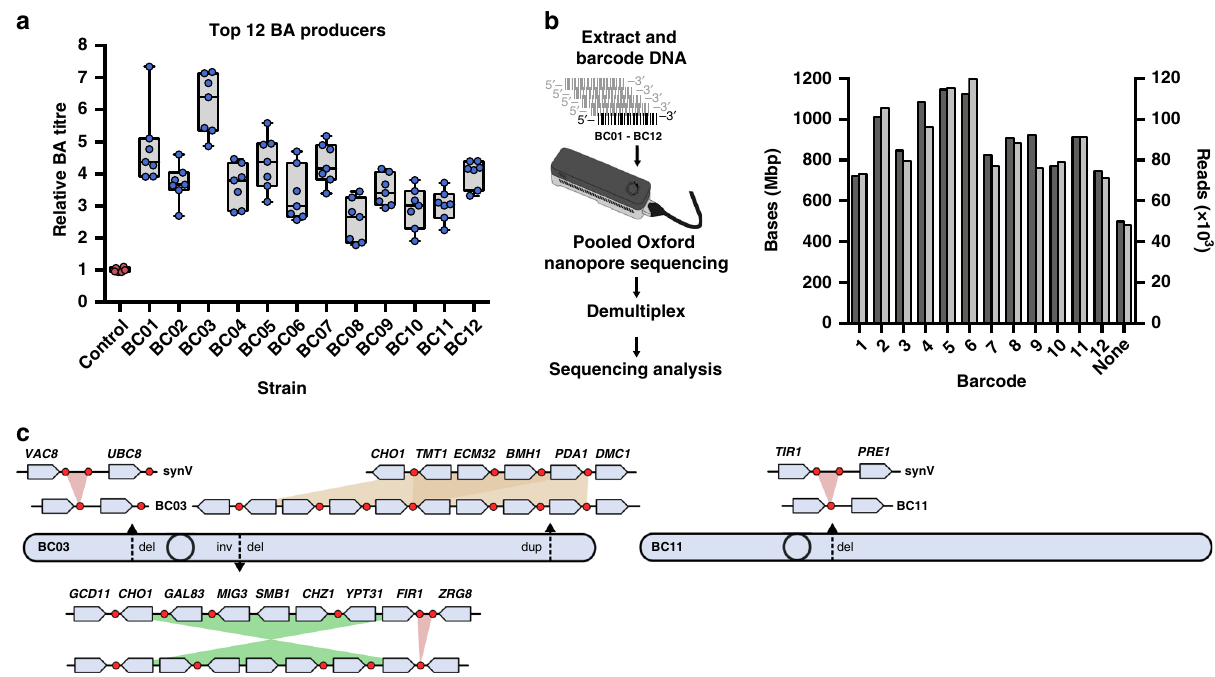
Fig. 2 Phenotype and genotyping of the top 12 BA producers by ultra-fast LC-MS and multiplexed nanopore sequencing. a The top 12 strains from the initial screen (BC01 – BC12), and the control strain (yGG066), were subject to reanalysis with n = 7 ( n = 6 for the control strain) biologically independent samples using the same extraction and LC-MS work fl ow as in the initial screen. Data are presented as a box plot centred around the mean with bounds between the 25th and 75th percentile. Whiskers represent minima and maxima. b DNA from each of the top 12 strains was extracted and barcoded with 12 unique barcodes (BC01 – BC12). The pooled DNA was then sequenced over 48 h. Throughput of bases (dark grey) and reads (light grey) was monitored to ensure no bias was introduced for a particular barcode. c Sequence analysis of the highest BA-producer, BC03 (left), indicates four SCRaMbLE events across three loci affecting ~20 kb of the chromosome. In contrast, BC11 (right) exhibits only a single non-coding deletion of 723 bp. Source data are provided as a Source Data fi